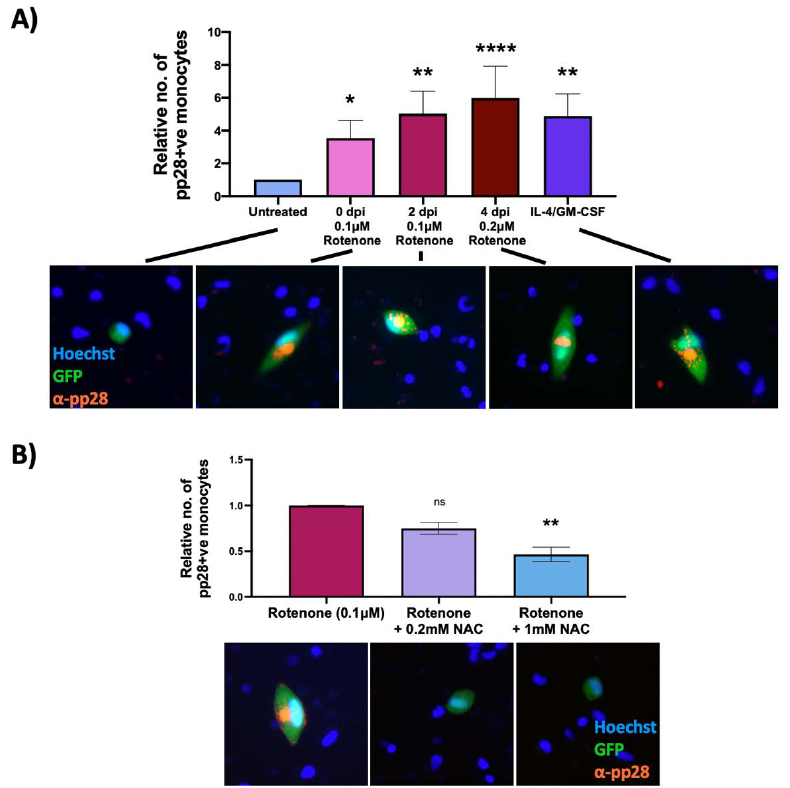
Figure 6. Rotenone induces reactivation of latent HCMV, which is prevented by an antioxidant. CD14+ monocytes were infected with WT TB40E SV40-GFP virus at an MOI of 5. Cells were ( A ) treated with rotenone at 0 (3 h.p.i), 2 or 4 d.p.i, or with IL4/GMCSF + LPS as a positive control for reactivation or ( B ) at 2 d.p.i were treated with 0.1 μM rotenone and increasing concentrations of the antioxidant, NAC. At 7 d.p.i, all cells were stained for the late lytic protein, pp28, and the number of pp28-positive monocytes counted. Graphs show mean relative numbers of pp28-positive monocytes in each condition from at least three independent repeats using 6 × 10 5 cells/repeat. Error bars represent standard deviation. Significant differences were determined using a nested one-way ANOVA with Dunnett’s post hoc testing. ns = not significant, * = p < 0.05, ** = p < 0.01, **** = p < 0.0001. Merged colour channel images for each condition were produced on ImageJ (20 × ). Exposure of green channel was reduced in some images for